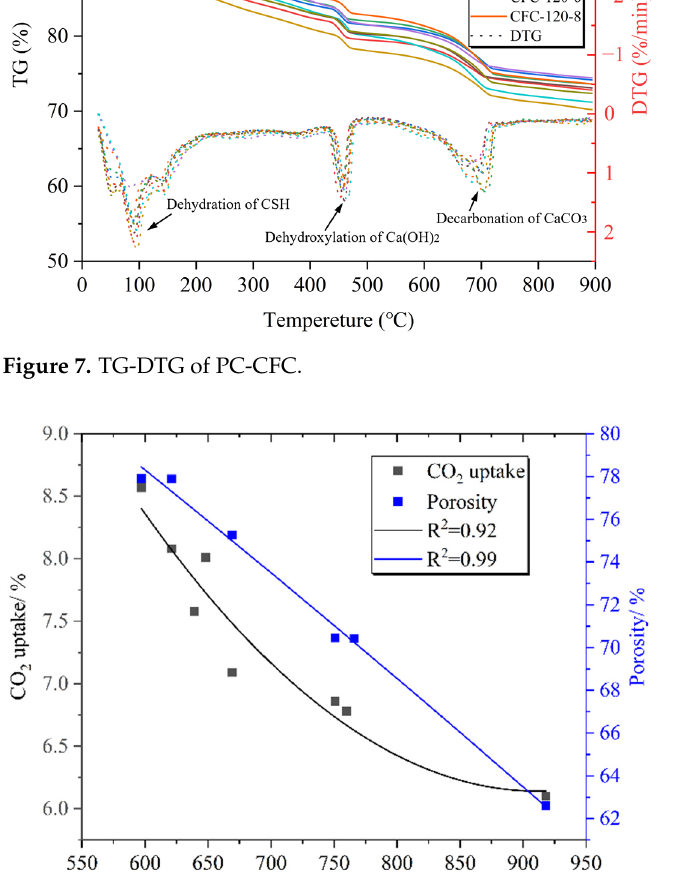
Figure 9. Relationship between the thermal conductivity and 28 d compressive strength and CO 2 uptake.